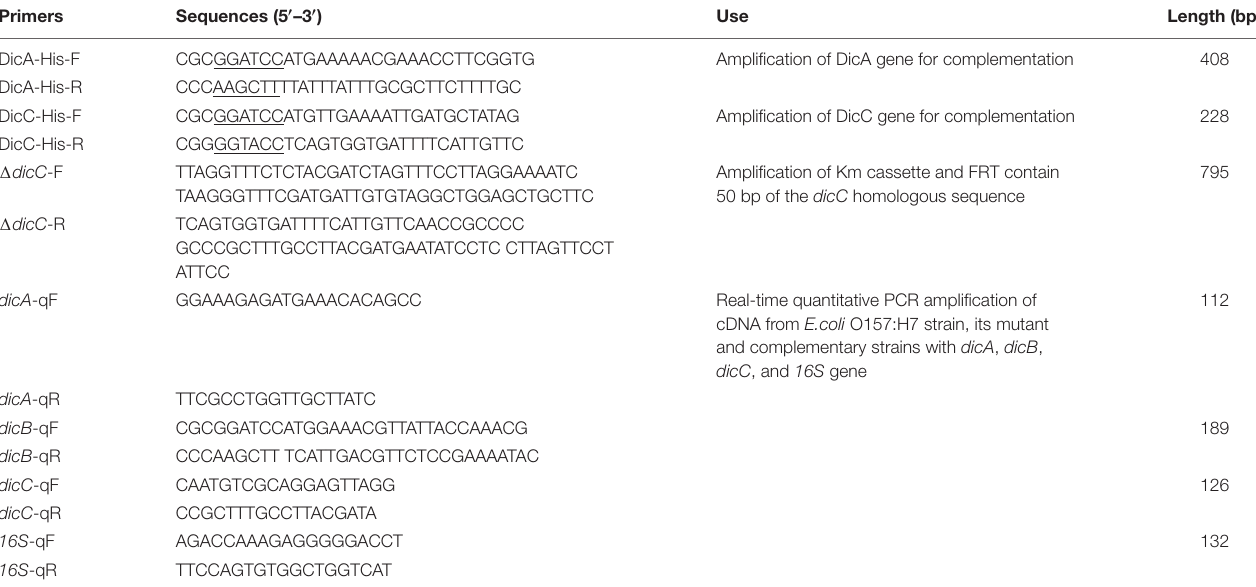
TABLE 2 | Primers used in this